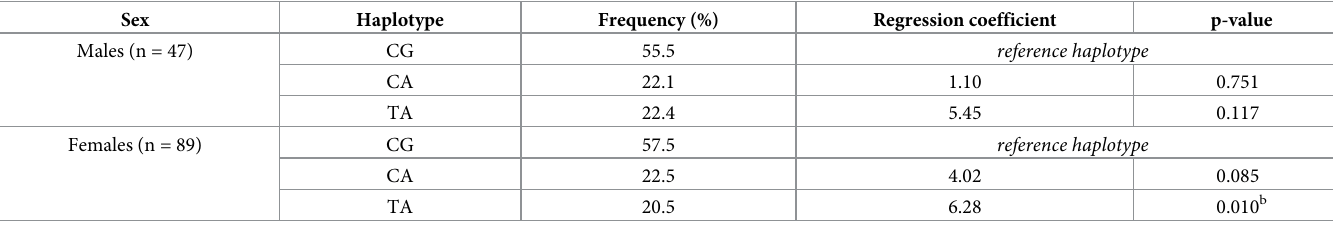
Table 8. Sex specific haplotype analysis of block 1 a rs9983698 [C > T]—rs9722 [G > A].